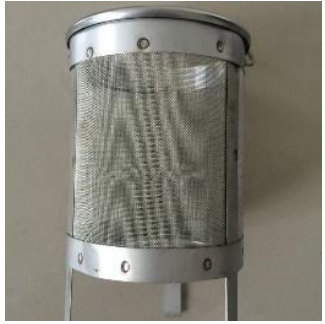
Figure 6. Basket used in the tests .